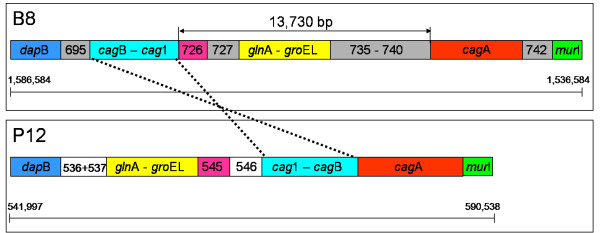
Similarity comparison of the cag-PAI regions of strain B8 and strain P12, restricted to the region between the dapB-gene and the murI-gene. Clusters of genes with homology are shown in the same color. Clusters of genes with no similarity in the other genome are drawn in grey (B8) and white (P12). In strain B8, the region delimited by the cag1-gene and the cagB-gene is inverted and located 13,730 bp upstream of the cagA-gene. A cluster of six genes (four singletons, two variable genes) is located between the groEL-gene and the cagA-gene.